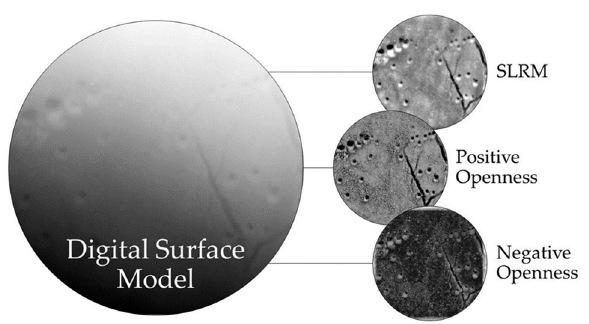
Figure 4. Different LiDAR visualisation techniques used for model training. Image originally published in Gallwey et al. (2019). Base DSM © Environment Agency